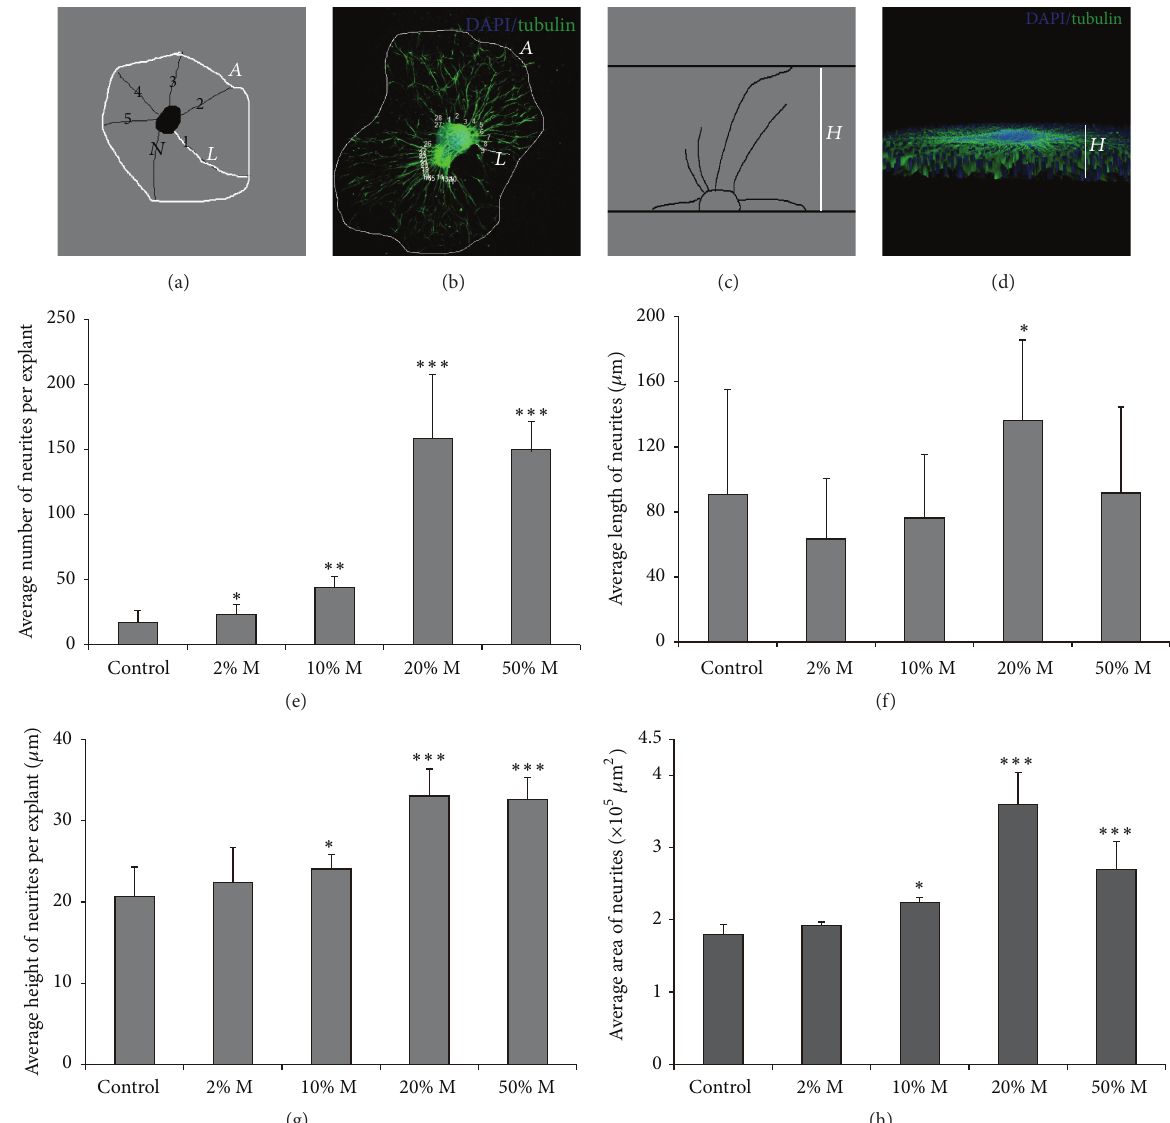
Figure 2: 3D-matrigel culture promoted neurite outgrowth of SGN explants. (a) The planar characteristics of SGN explants, the number (𝑁) , the length (𝐿) , and the area (𝐴) of neurites, were measured. (b) SGN explant as the illustration for number, length, and area of neurites. (c) The schematic of the height (𝐻) of neurites in SGN explant. (d) SGN explant as the illustration for the height of neurites. (e–h) Quantifications of the average number, length, height, and area of neurites. ∗ 𝑝 < 0.05 , ∗∗ 𝑝 < 0.01 , and ∗∗∗ 𝑝 < 0.001